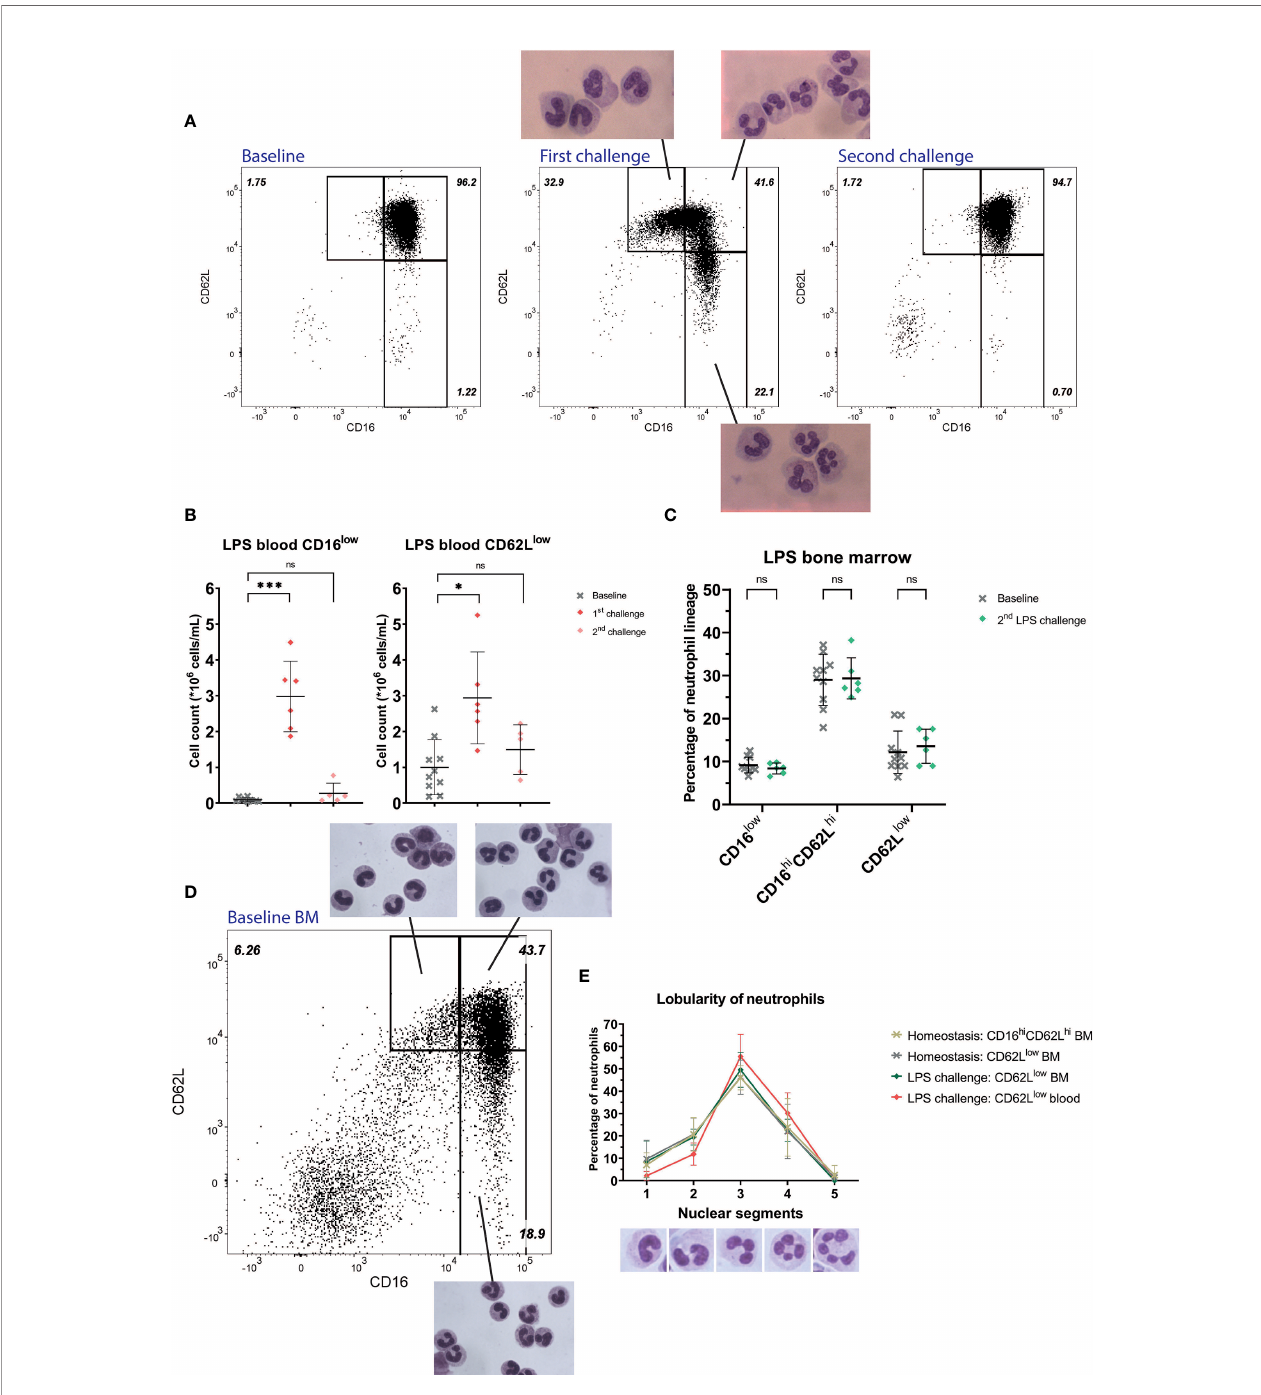
FIGURE 1 | Healthy volunteers undergoing LPS challenge. Representative FACS examples of CD16/CD62L plots of blood from a healthy subject at baseline ( fi rst panel), 4 hours after the fi rst LPS challenge with corresponding cell morphology of the speci fi c subsets (second panel) and 4 hours after the second LPS challenge (third panel) (A) . Cell counts of CD16 low neutrophils ( fi rst graph) and CD62L low neutrophils (second graph) at baseline (n=10), after the fi rst (n=6) and second (n=5) LPS challenge. Lines are means with SD. A one-way ANOVA analysis (paired) with a post-hoc Dunnett ’ s multiple comparisons test was used to test signi fi cance (B) . Percentages of neutrophil subsets in bone marrow (BM) and after the second LPS challenge. Lines are means with SD. A two-way ANOVA analysis (paired) with a post-hoc Sidak ’ s multiple comparisons test was used to test signi fi cance (C) . Representative FACS example of CD16/CD62L plot of bone marrow from a healthy volunteer at baseline with the corresponding cellular morphology for the different subsets (D) . Percentages of nuclear lobes of CD62L low neutrophils (ranging from 1 to 5) during homeostasis in bone marrow and during LPS challenge in bone marrow and blood. Lines are means with SD (E) . Signi fi cance is displayed in graphs as ns, not signi fi cant, P* ≤ 0.05 or P*** ≤